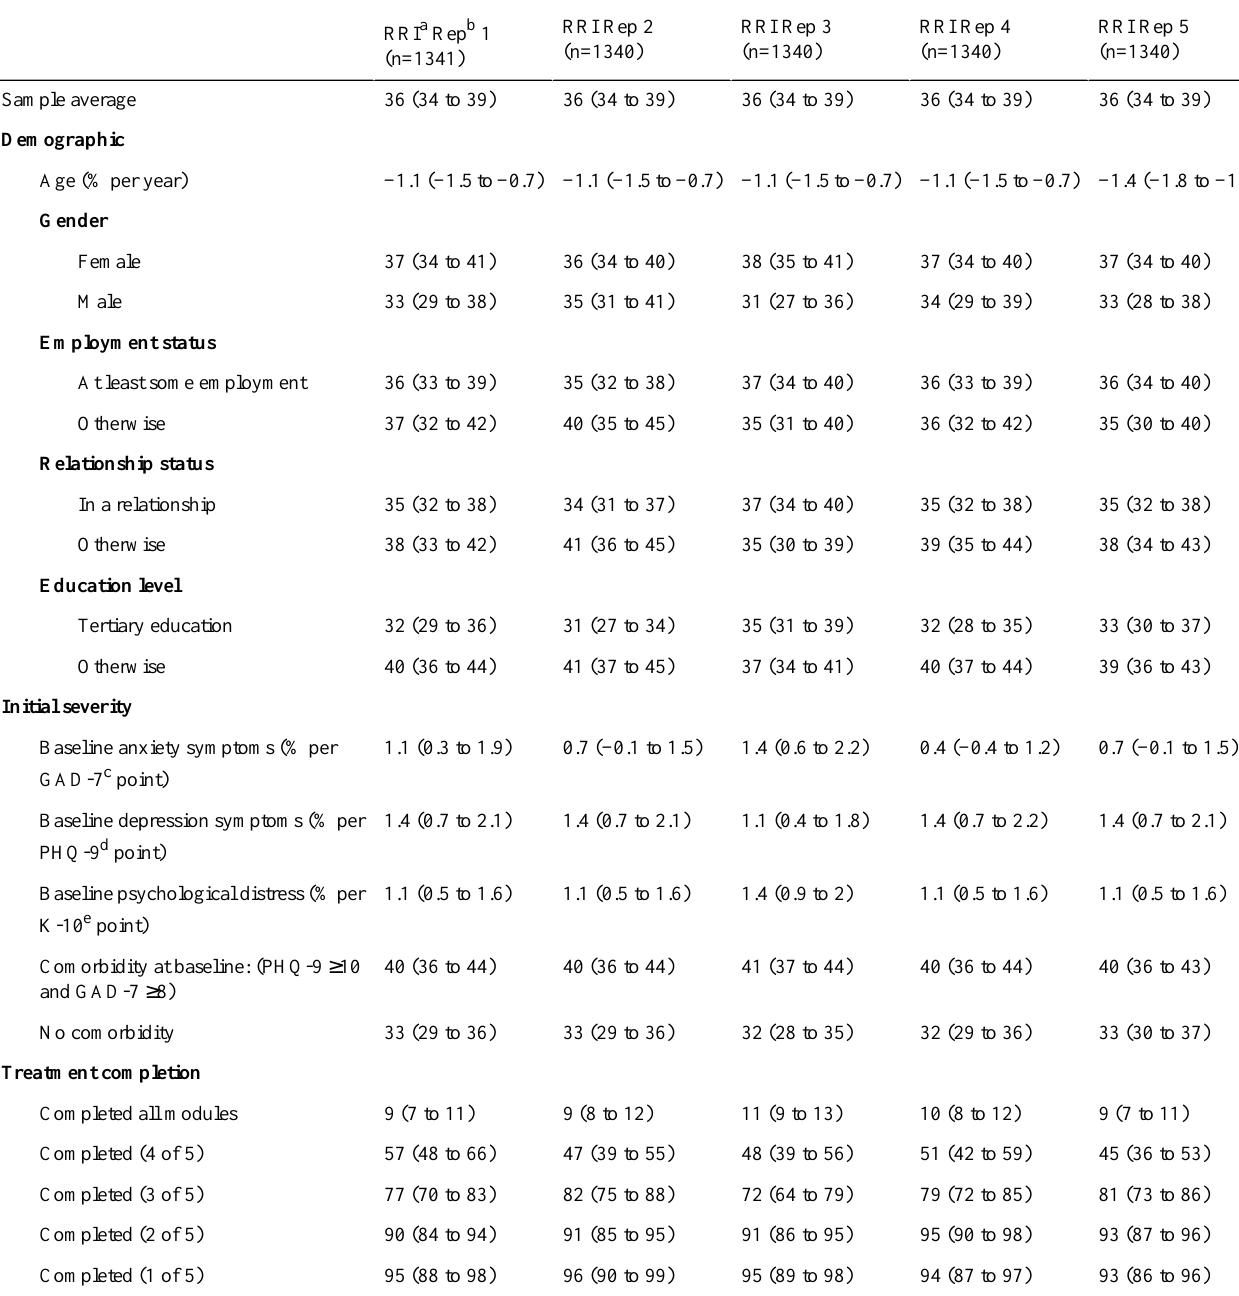
Table 4. Univariate missing cases probability replication models across the five random cross validation samples (N=6701). Probability estimate of missing values at posttreatment in replication subsamples (95% CI)Variable